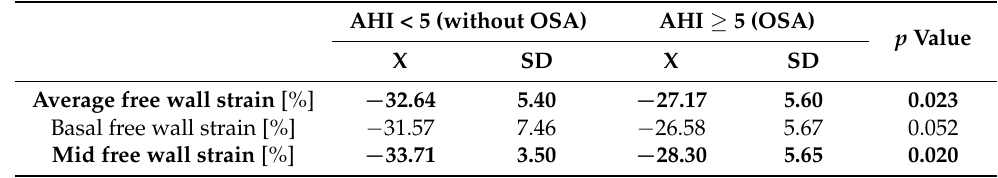
Table 5. Right ventricular strain parameters in subgroups separated based on OSA (statistically significant differences between the groups were